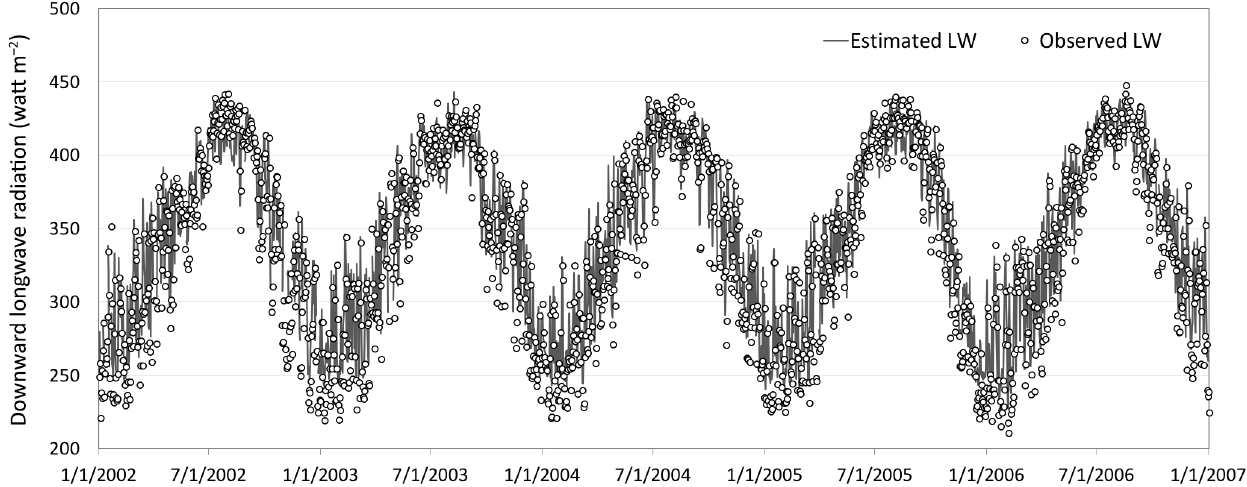
Figure 3. Comparison of estimated and observed downward longwave radiation at the EDP site from 1 January 2002 to 31st December